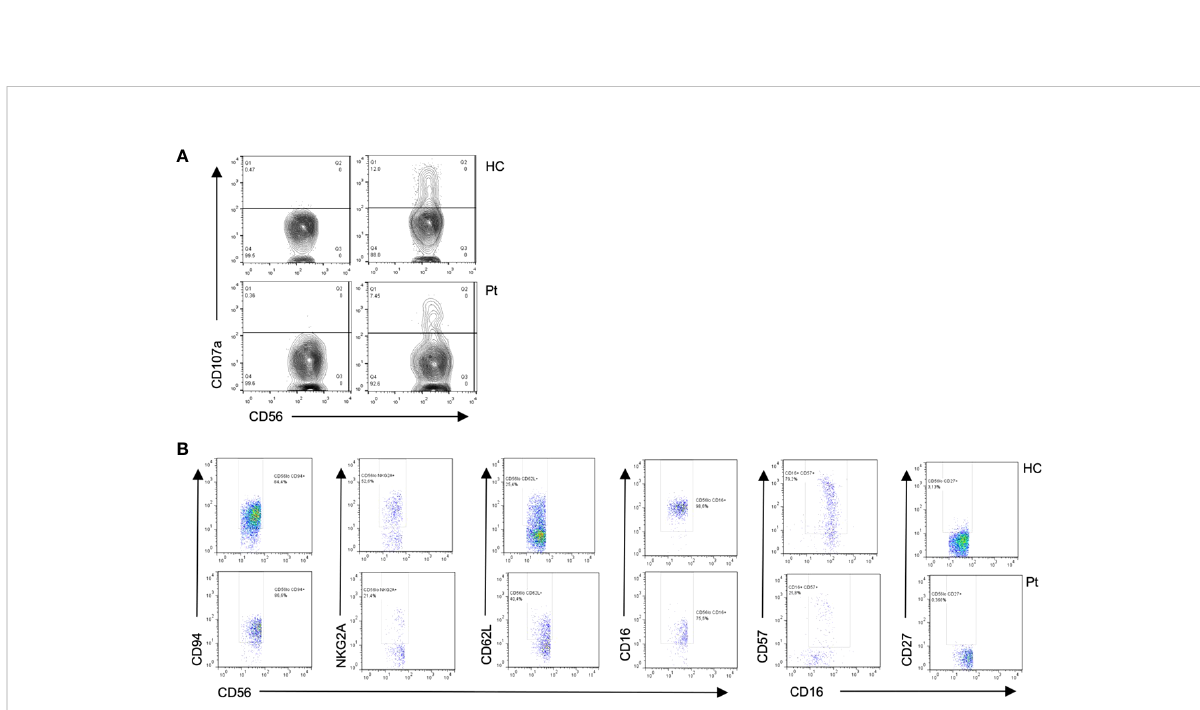
FIGURE 4 Flow cytometry from patient 1 shows (A) Diminished degranulation in Natural Killer (NK) cells from the patient (P) as compared to healthy control (HC). (B) Abnormal cell surface marker expressions in NK subsets cells from the patient as compared to healthy control, suggesting impaired NK cell